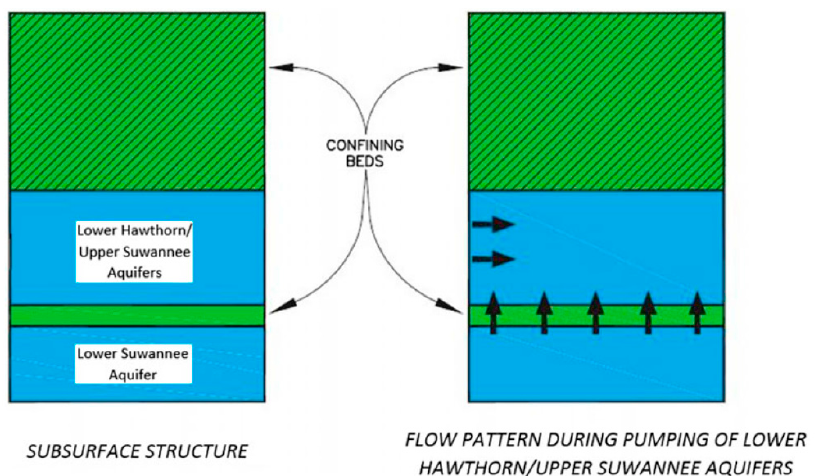
Figure 1. General model of groundwater flow during aquifer pumping showing the upwards recharge of the pumped aquifer Drendal [20].